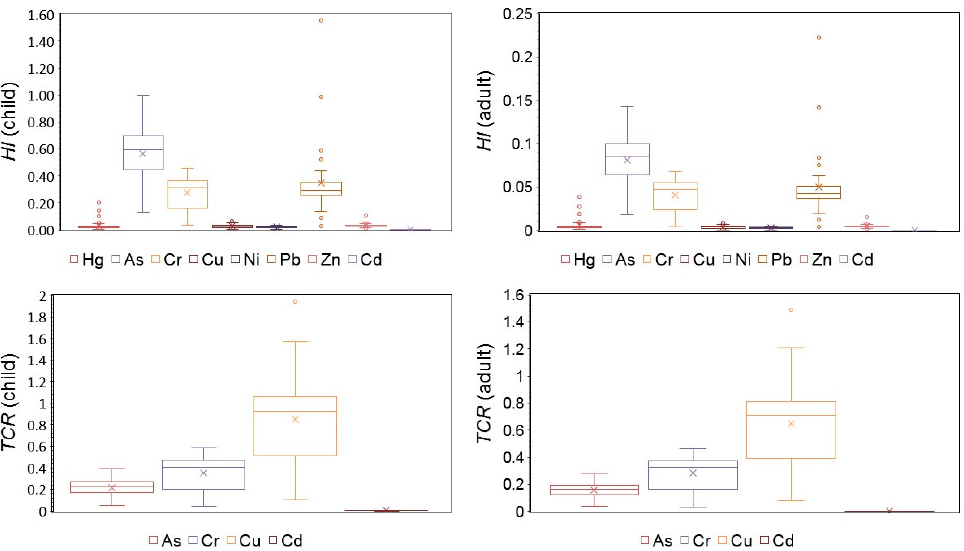
Figure 6. The hazard index (HI) and total cancer risk (TCR) value for human health risk with respect to both children and adults.